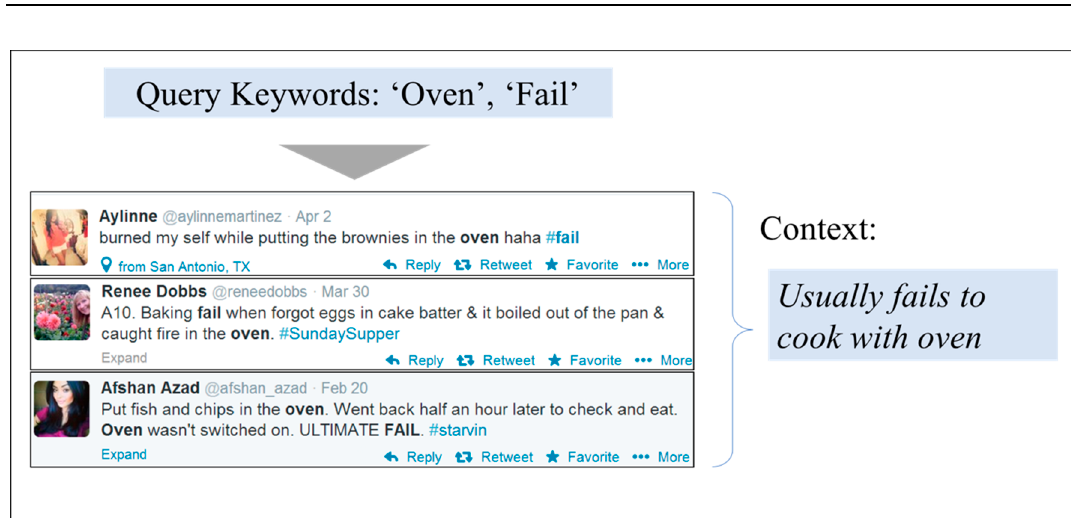
Figure 7. Tweets and discovered context in the concept space with ‘oven’ and ‘fail’.